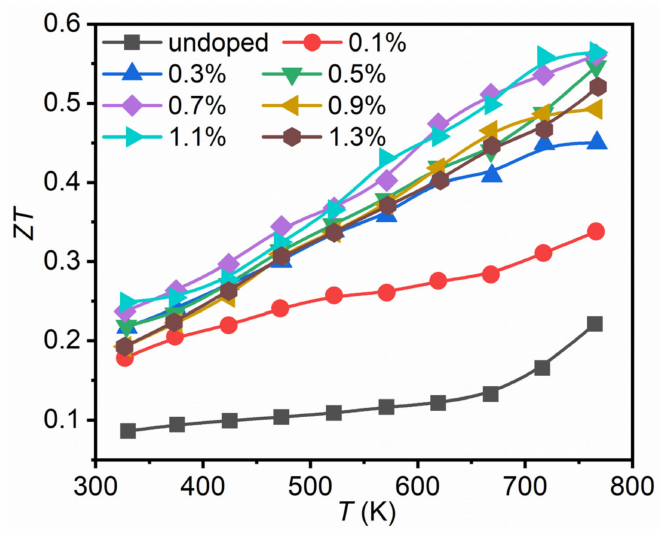
Figure 6. Dimensionless figure of merit ( ZT ) for Bi 2 Se 1 − x I x S 2 (x =